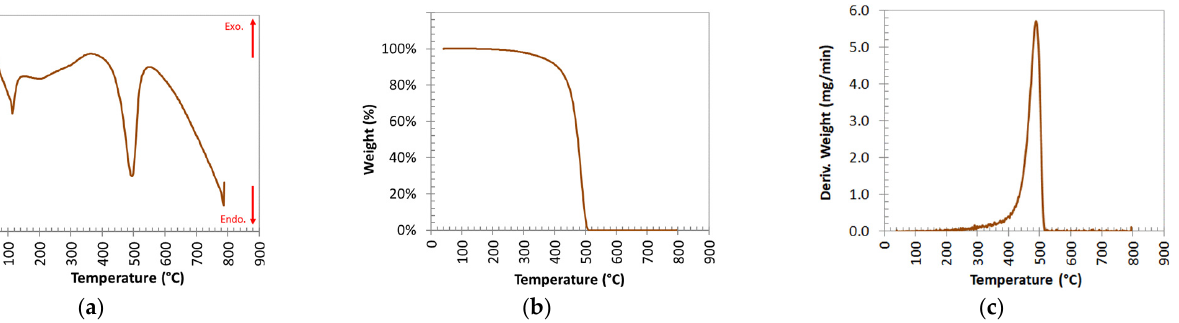
Figure 3. Dynamic rheology: ( a ) dynamic shear rheometer; ( b ) its operating mode.